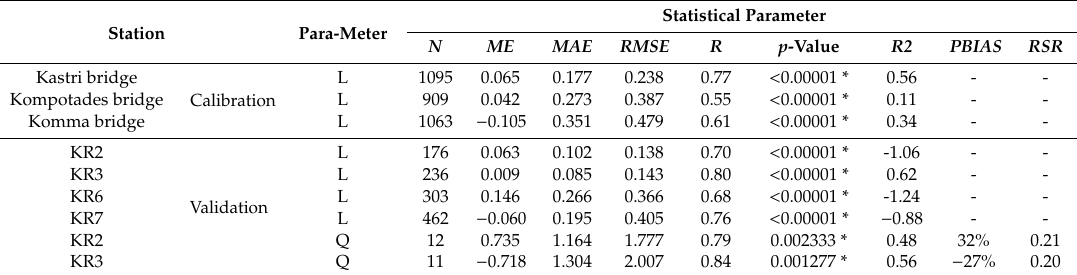
Table 1. Statistical characteristics and e ffi ciency criteria for the calibration and validation of the hydrological model at the Spercheios river basin